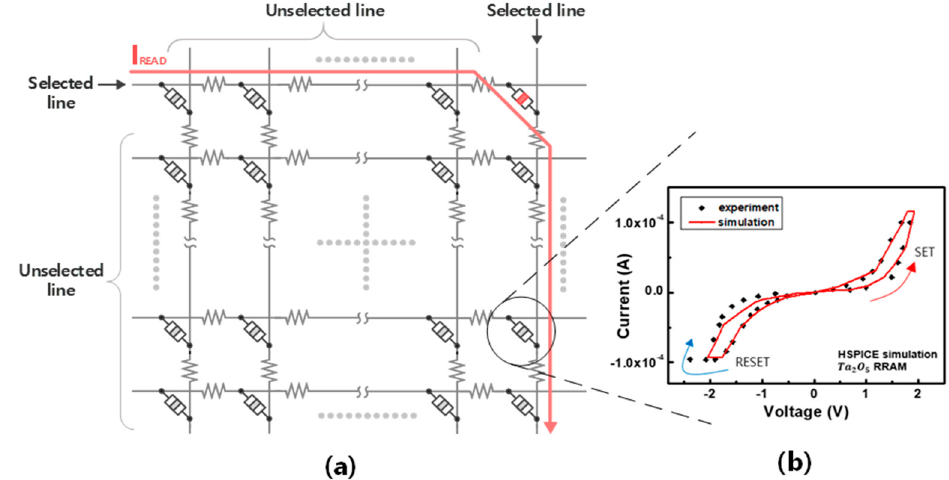
Figure 1. ( a ) The structure of a nano cross ‐ point array; and ( b ) the currentvoltage (I ‐ V) characteristics of a 𝑇𝑎 (cid:2870) 𝑂 (cid:2873) memristor implemented in ( a ). The black diamond ‐ shaped dots show the experimental results for a 𝑇𝑎 (cid:2870) 𝑂 (cid:2873) memristor obtained from [21] and the red line shows the simulated